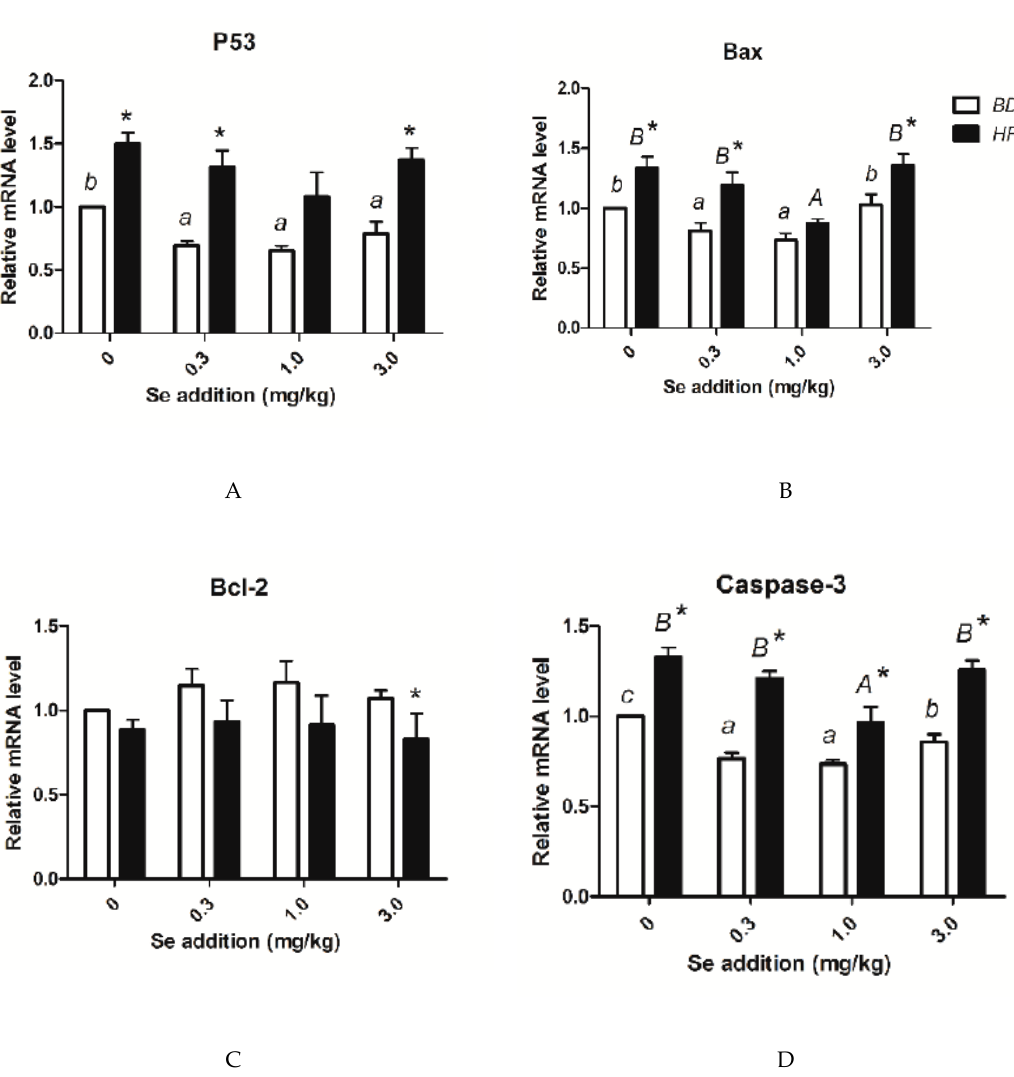
Figure 5. Levels of apoptosis gene mRNA. ( A ) The mRNA level of P53; ( B ) the mRNA level of Bax; ( C ) the mRNA level of Bcl-2; ( D ) the mRNA level of Caspase-3. * Di ff erent from the BD at that Se addition, p < 0.05. a–c Within BD groups, means without a common letter di ff er, p < 0.05. A–B Within Figure 5. HFD groups, means without a common letter di ff er, p <